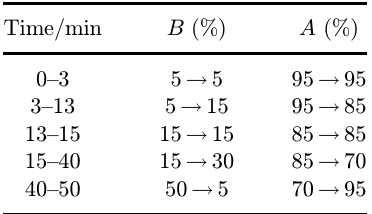
Table 1. Gradient elution